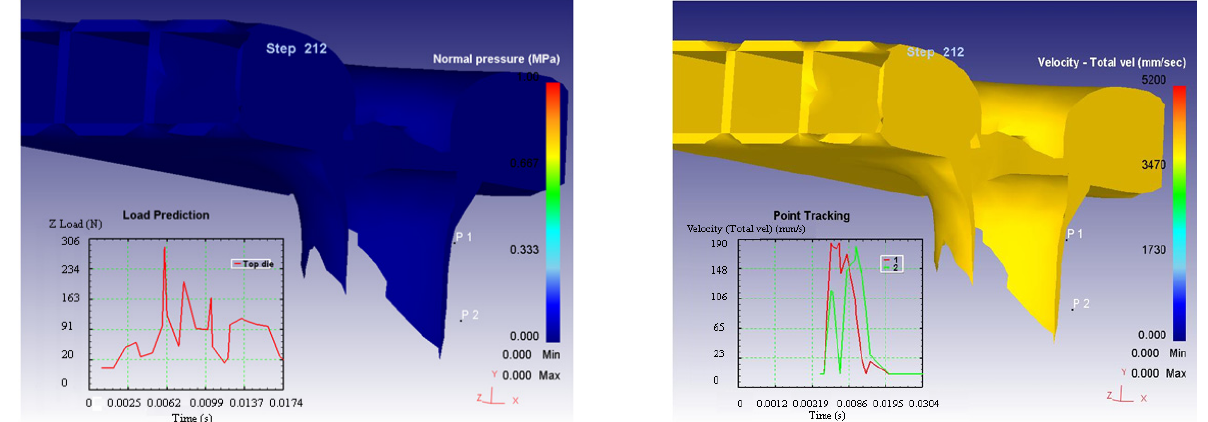
Figure 9. Variation on the 3 axes of the strain force and velocity.